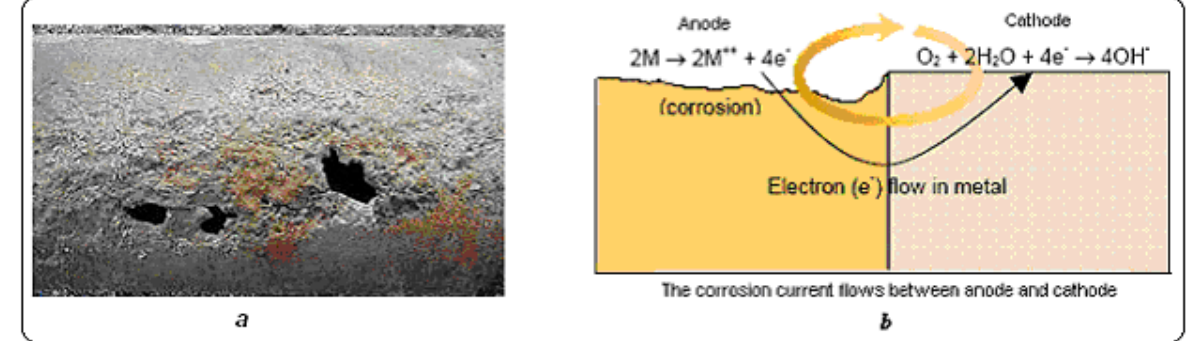
Figure 3. (a) Corrosion effects on pipelines; (b) corrosion